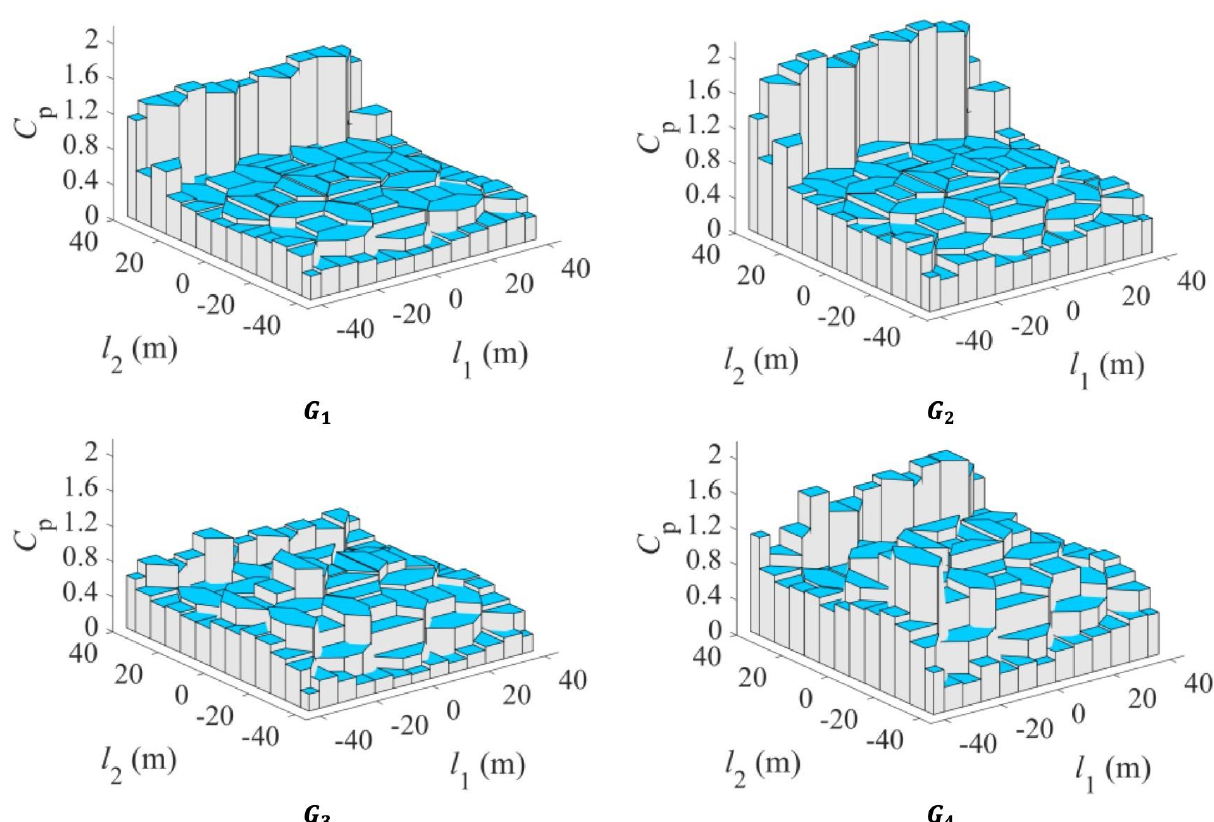
Figure 3: Mean pressure coeflcients of square plan geometries with θ = 0 ∘